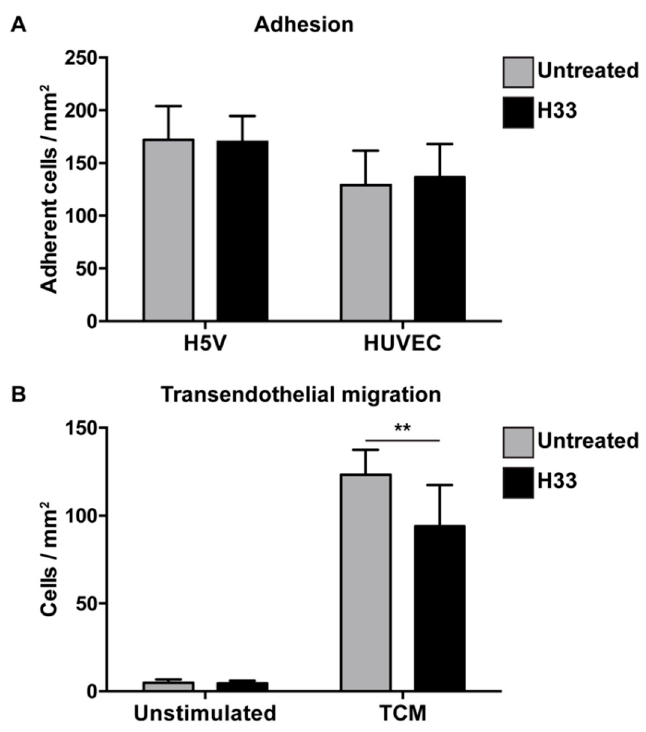
Figure 2. Blocking JAM-C via monoclonal antibody: Effect on e-EPC adhesion and transendothelial migration in vitro. ( A ) Adhesion: Human umbilical vein endothelial cell (HUVEC) monolayers were preincubated in the absence (untreated) or in the presence of H33 anti-JAM-C monoclonal antibody. The fluorescence of cell-tracker green-labeled adherent cells was measured. Data are represented by mean ± SD ( n = 3). ( B ) Transendothelial migration: A transwell system was used. HUVEC monolayers and e-EPCs were in the absence (untreated) or presence of anti-JAM-C antibody H33. e-EPCs were then plated in the upper chamber onto the HUVEC monolayer to transmigrate in response to tumor-conditioned medium (TCM) or not (unstimulated). Transmigrated cells were stained with DAPI and counted using a fluorescence microscope. Data are represented by mean ± SD ( n = 3); ** p < 0.01.